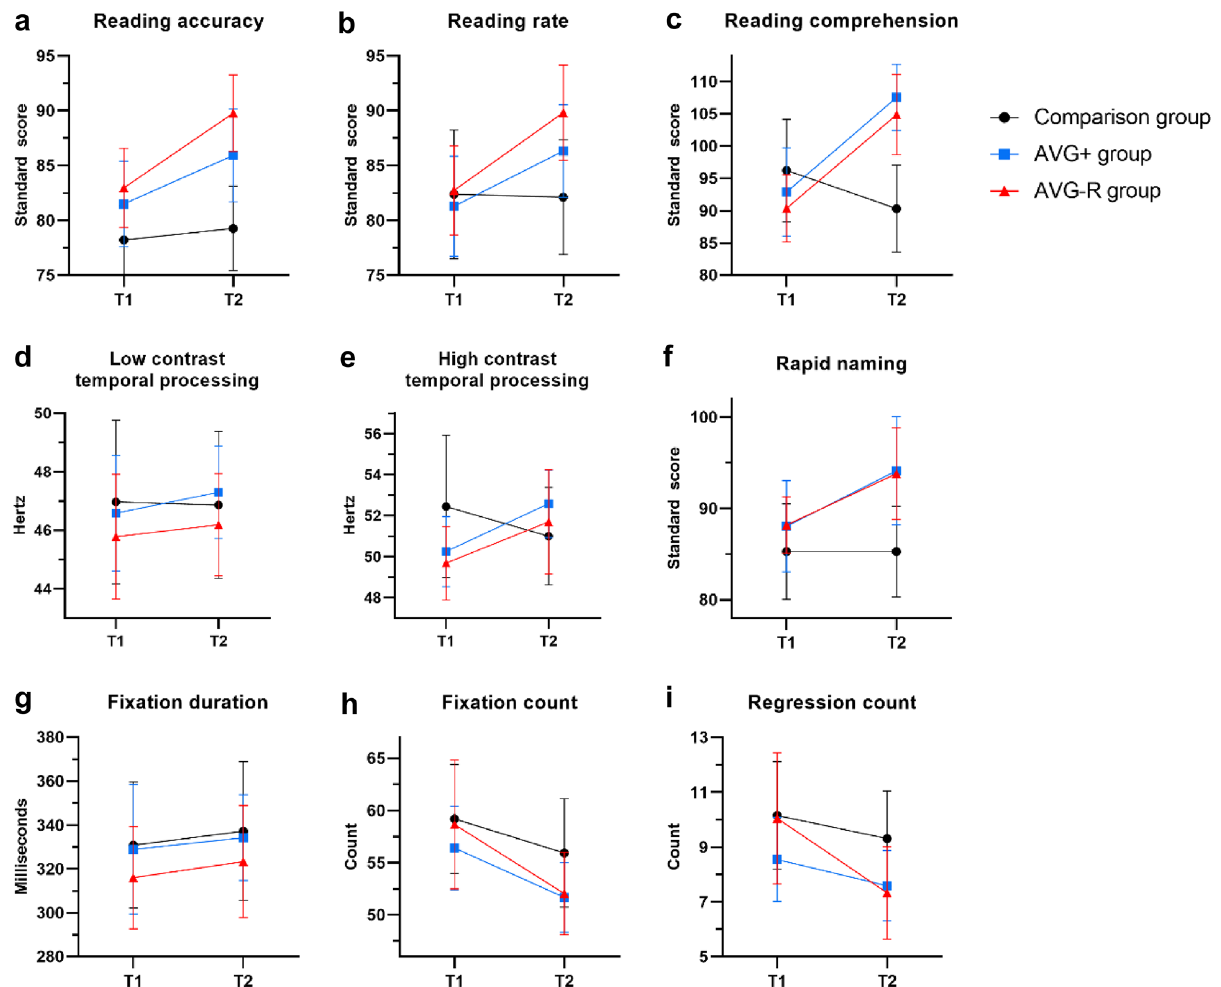
Figure 1. Dyslexic children’s performances before (T1) and after (T2) AVG+ training, AVG-R training or treatment-as-usual (comparison group) on ( a ) reading accuracy, ( b ) reading rate, ( c ) reading